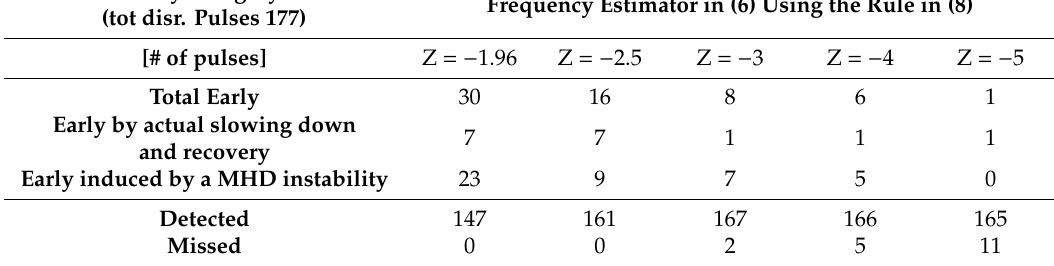
Table 2. “Early” category study regarding the disruptive pulses. The table reports the comparison between the threshold based indicators, currently used in control room at AUG, and the estimator in (6), used for the tracking of the dynamic of the